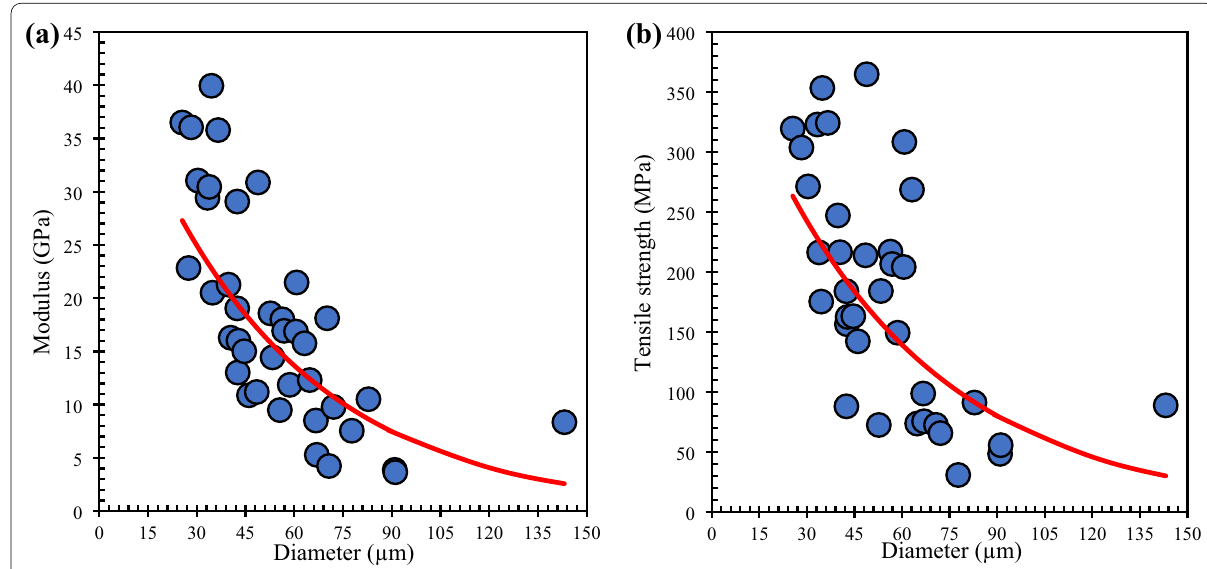
Fig. 7 Variation in a tensile modulus and b tensile strength of virgin cattail with fiber